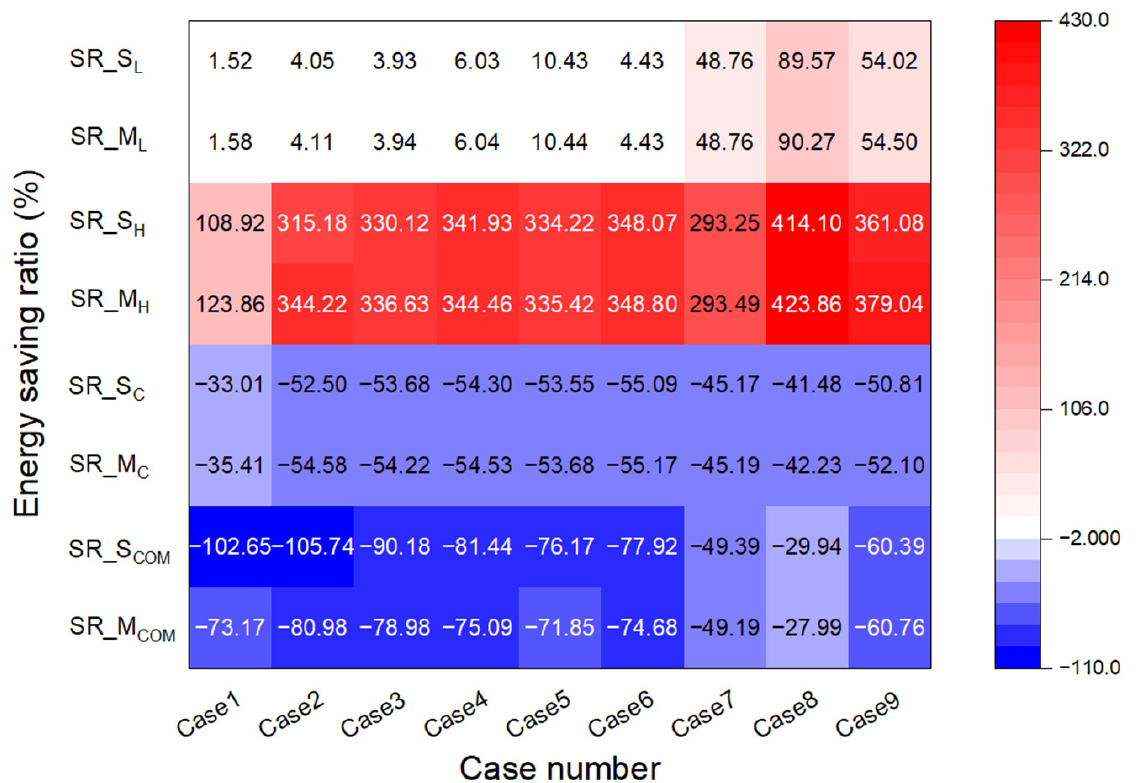
Figure 16. Energy saving analysis of building with different PVSDs in Kunming.